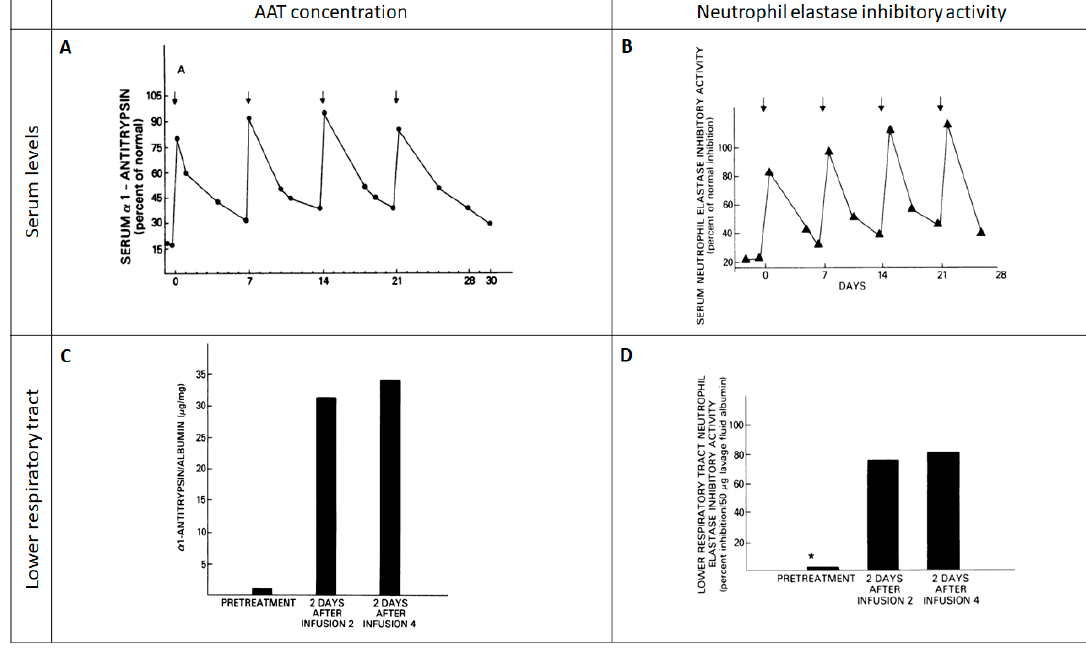
Figure 2. Initial study evaluating the biochemical efficacy of AAT augmentation therapy. Reproduced with permission from Reference [6]. ( A ) The response of serum al-antitrypsin levels to the infusion of 4.0 g of AAT. ( B ) Serum neutrophil elastase inhibitory activity following weekly intravenous infusions of 4.0 g of AAT. ( C ) Lower respiratory tract al-antitrypsin levels during intravenous replacement therapy with 4.0 g of AAT. ( D ) Lower respiratory tract neutrophil elastase inhibitory activity following weekly intravenous infusions of 4.0 g of AAT.